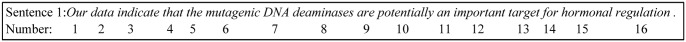
The sequence number of tokens in sentence 1.